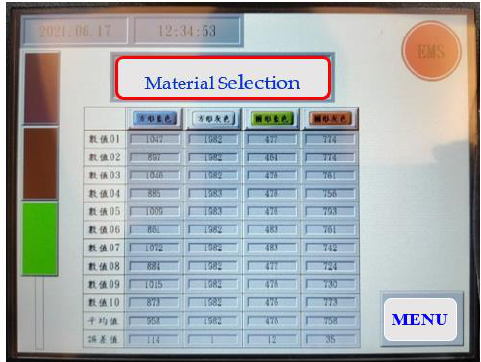
Figure 10. Test results for material colors.